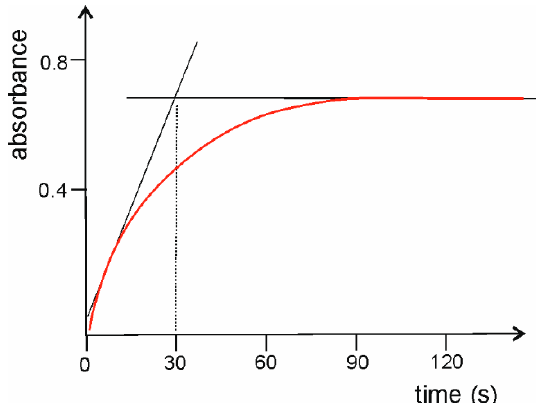
Figure 1. The typical analytical signal obtained for Fe(II) determination. Sample: Fe(II) 10 mg L − 1 ; reagent: 1% solution of 1,10-phenanthroline in sodium acetate (1 mol L − 1 ) and ethanol (25:5, v / v ); carrier, water.